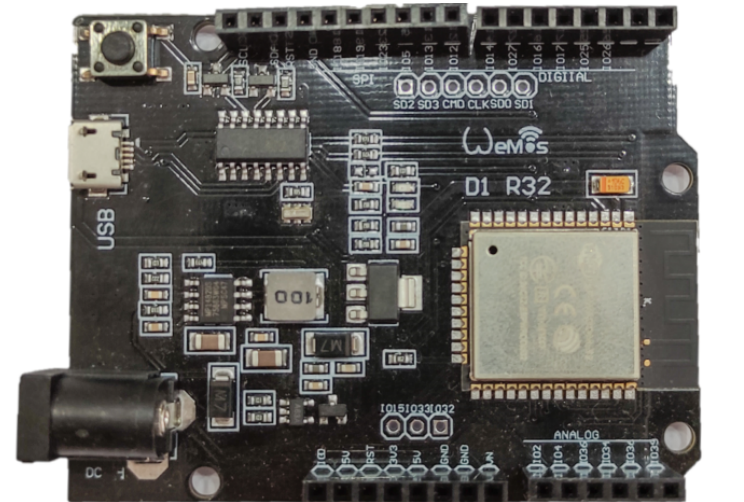
Figure 3. Arduino format ESP32 MCU